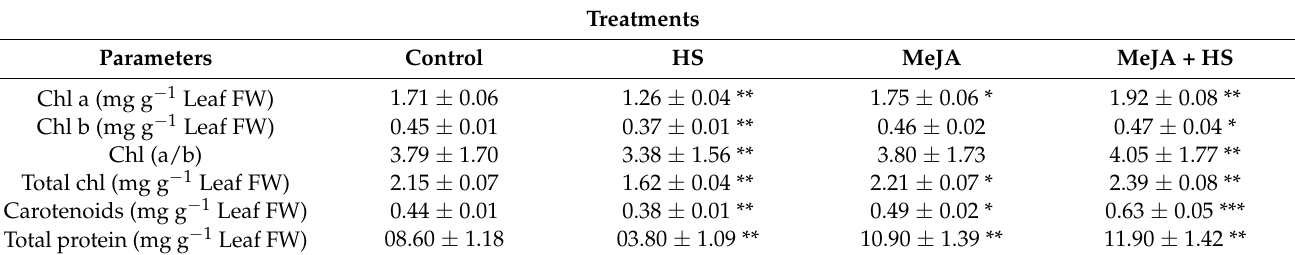
Table 4. Content of Chl a, Chl b, Chl (a/b) ratio, total Chl, and carotenoids in wheat leaves at 30 DAS. Plants were treated with MeJA (10 µ M) at 42 ◦ C (heat stress) or 25 ◦ C (no stress). Data are presented as mean ± SE ( n = 4). Significantly different values between control and treatments are marked with an asterisk (* p < 0.05, ** p < 0.01, *** p < 0.001), as determined by Tukey’s test. Chl, chlorophyll; DAS, days after sowing; FW, fresh weight; HS, heat stress; MeJA, methyl